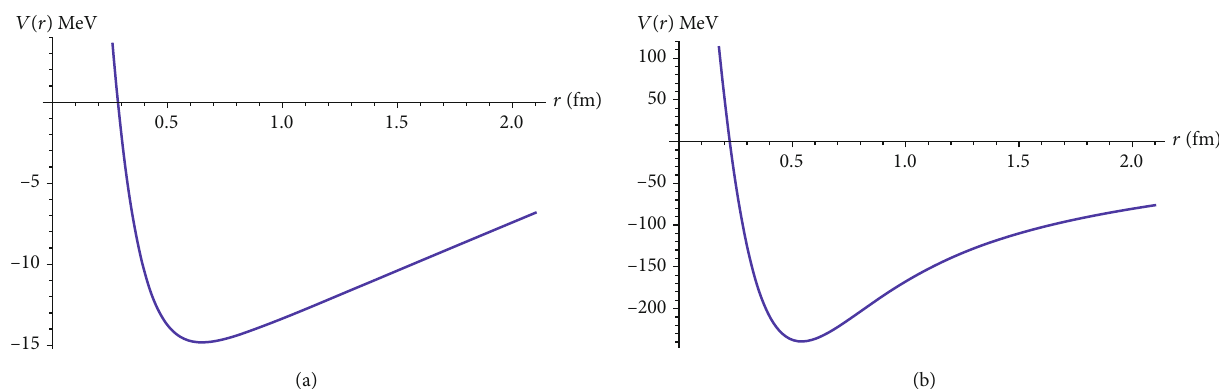
Figure 7: The potential with GY and SPED functions, respectively, of 2 H nuclei as OBEP through the exchange of π , σ , and ω mesons, with parameter II.